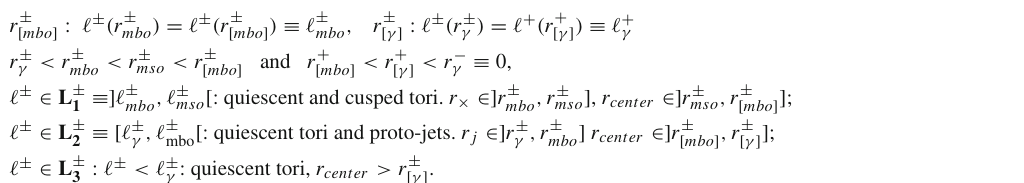
circular (photon) orbit and the marginally bounded orbit for (cid:6) + and (cid:6) − specific angular momentum. Relation between radii { r ± mso , r ± γ , r ± characterizes fluids with (cid:6) + and (cid:6) − at NSs spins a > a 2 – see Table 2 – where there is r − γ ≡ 0. Radii { r ± [ extended geodesic structure. There is (cid:6) − γ = a and r − [ γ ] = a 2 – see also Fig.